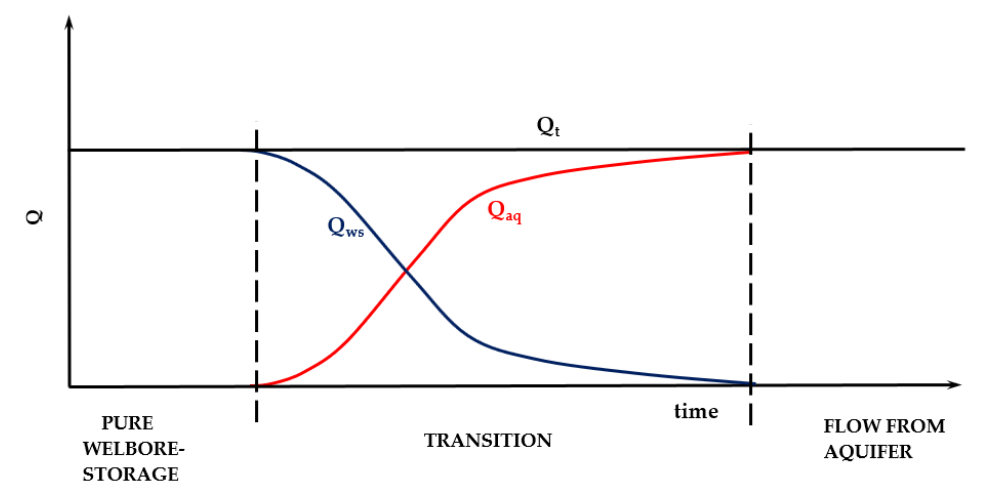
Figure 1. Pumping rate from wellbore storage, Q ws , and groundwater inflow rate from aquifer, Q aq , as a function of time.